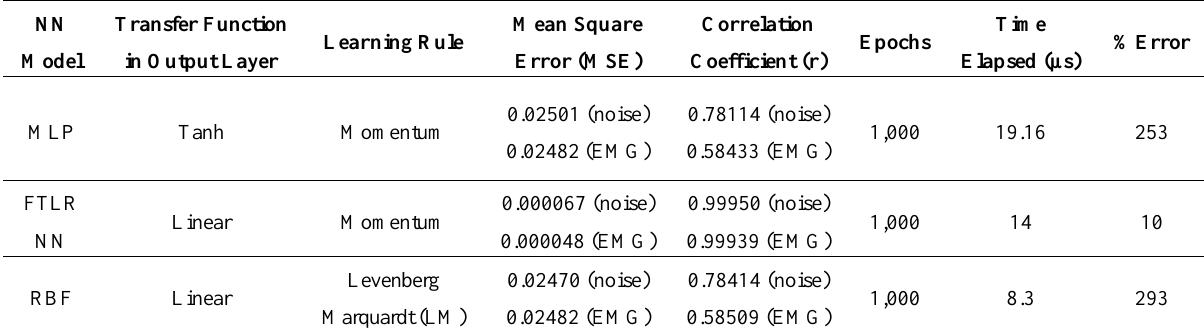
Table 3. Comparison of all the NN architectures on test dataset